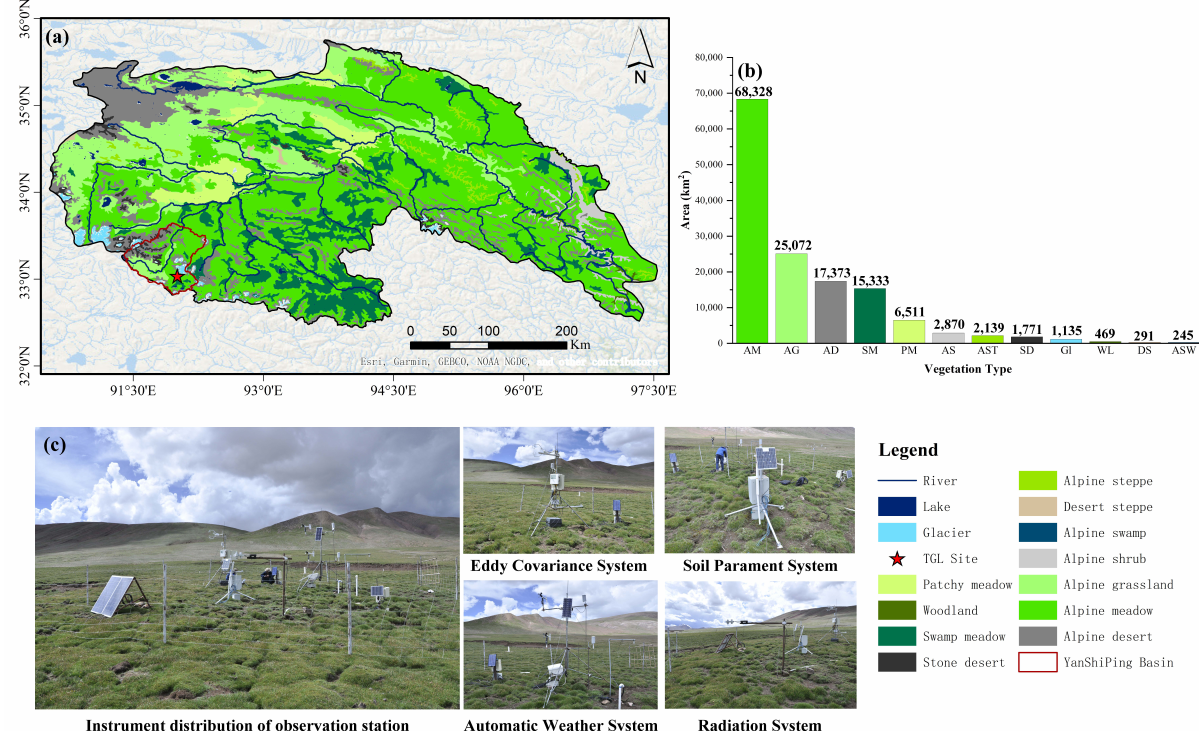
Figure 1. ( a ) Map of the vegetation type of the source region of the Yangtze River (SRYR), which is located in in the interior Qinghai–Tibet Plateau (QTP). [Editorial Board of Vegetation Map of China, Chinese Academy of Sciences, 2001]. ( b ) Proportion of vegetation and underlying surface types in the SRYR: AM, Alpine meadow; AG, Alpine grassland; AD, Alpine desert; SM, Swamp meadow; PM, Patchy meadow; AS, Alpine shrub; AST, Alpine steppe; SD, Stone desert; Gl, Glacier; WL, Woodland; DS, Desert steppe; ASW, Alpine swamp. ( c ) Distribution of instruments of the observation station and photos of the Eddy covariance system, soil parameter system, automatic weather system, and radiation